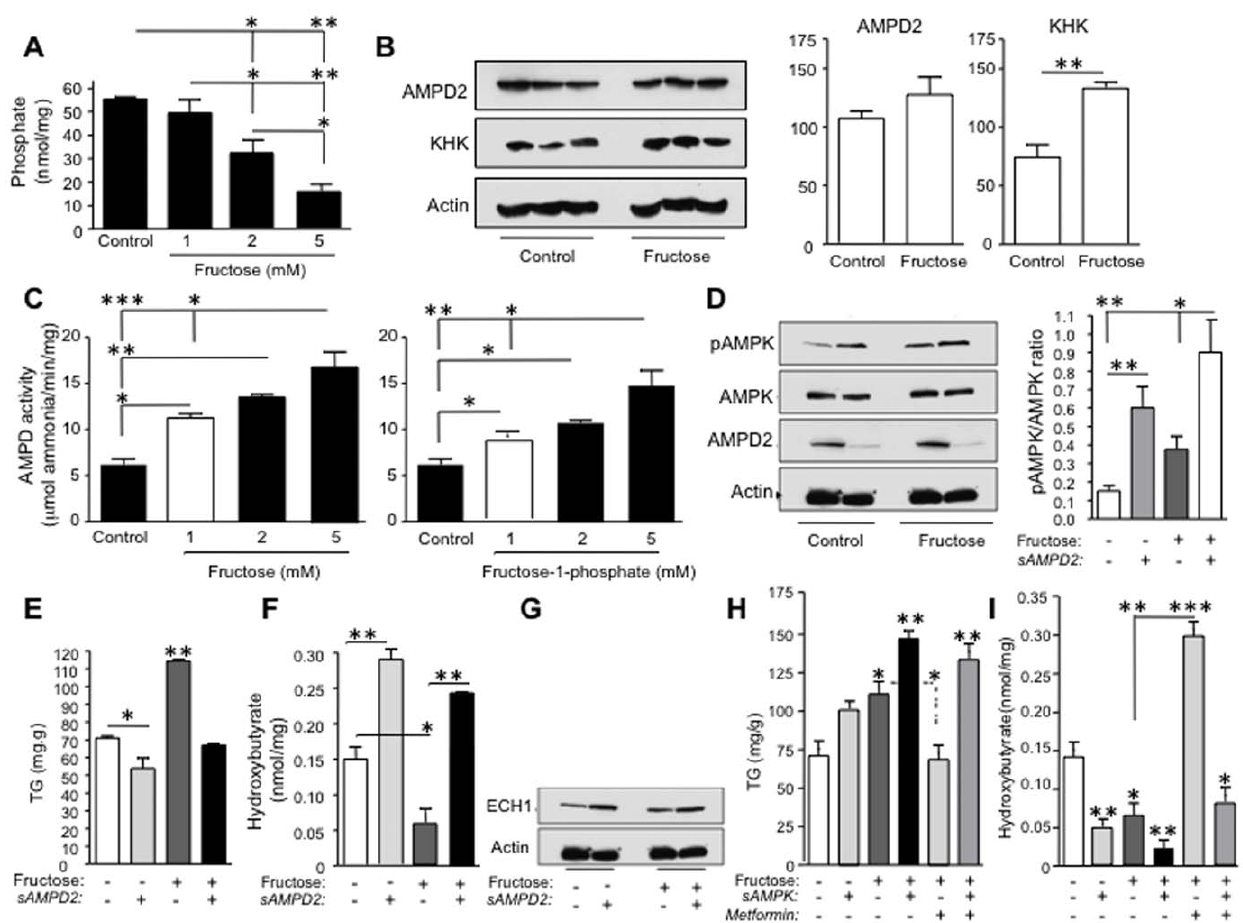
Figure 5. Fructose stimulates fat accumulation in HepG2 cells by activating AMPD2 and blocking AMPK and fat oxidation. A) Fructose reduces intracellular phosphate levels –a natural inhibitor of AMPD activity- in a dose-dependent manner. *p , 0.05, **p , 0.01. B) AMPD2 expression is not modified by fructose in human hepatocytes. As control, fructokinase (KHK) expression is significantly up-regulated. **p , 0.01. C) Both fructose (1–5 mM) and fructose-1-phosphate (1–5 mM) -the product of fructokinase metabolism- significantly up-regulates the activity of AMPD2 in human hepatocytes. AMPD activity was measured after 30 minutes exposure to fructose in 50 m g protein lysates *p , 0.05, **p , 0.01. D) Fructose stimulates AMPK activity (as determined by phosphorylation at Thr172) that is further amplified in AMPD2 silenced cells. *p , 0.05, **p , 0.01. E) Fructose induces triglyceride accumulation in HepG2 cells that is blocked in AMPD2 deficient cells *p , 0.05, **p , 0.01 F) Fructose decreases b - hydroxybutyrate levels in HepG2 cells that are blocked in AMPD2 deficient cells *p , 0.05, **p , 0.01. G) ECH1 expression is up-regulated in AMPD2 deficient cells exposed to fructose. H) Silencing AMPK expression increases triglyceride accumulation in non-exposed and fructose exposed HepG2 cells that is not blocked with 10 m M metformin *p , 0.05, **p , 0.01 I) Silencing AMPK expression decreases intracellular b - hydroxybutyrate levels in non-exposed and fructose exposed HepG2 cells that is not blocked with 10 m M metformin *p , 0.05, **p , 0.01, ***p , 0.001.